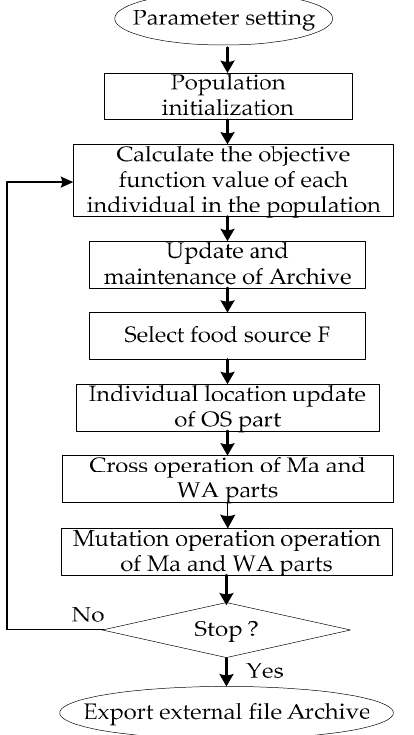
Figure 1. Flowchart of a multi-objective hybrid salp swarm algorithm.